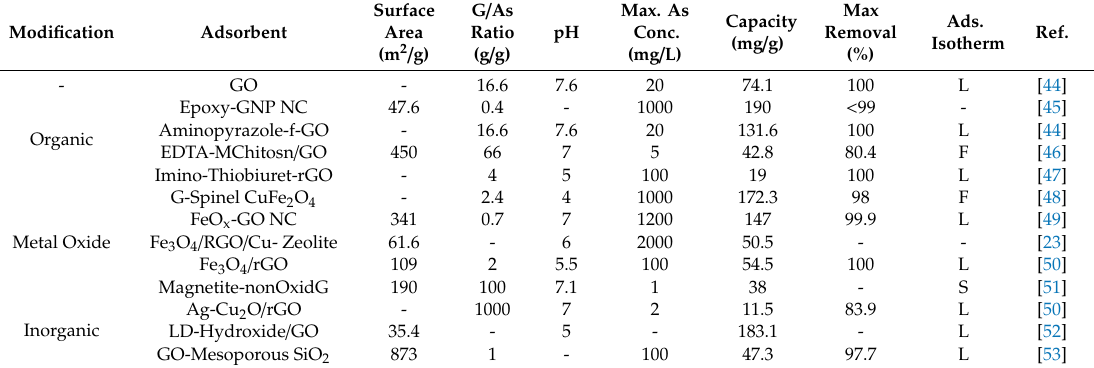
L: Langmuir, F: Freundlich, S: Sips.